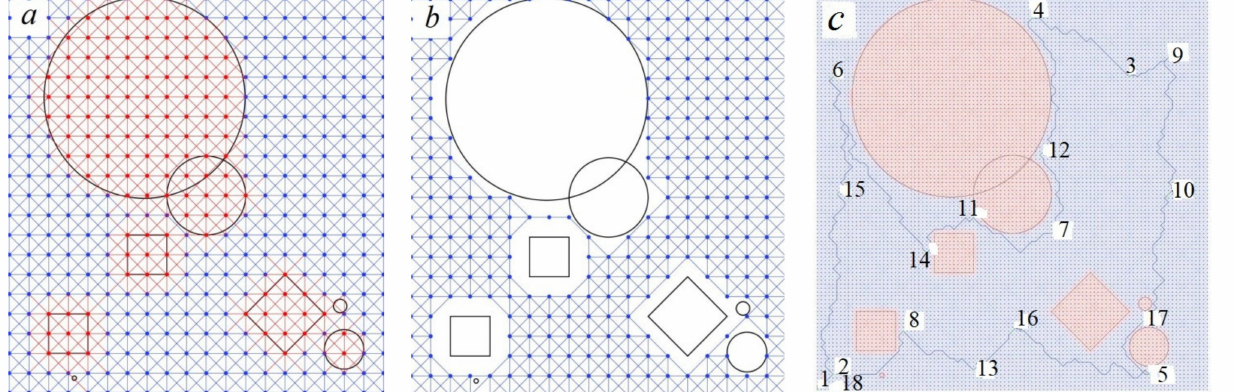
Figure 2. Steps to find the optimal route to bypass 18 points (circles and rectangles represent obstacles): ( a ) plan of the NPP room with a grid and points to be visited, ( b ) elimination of grid nodes taking into account obstacles, ( c ) the best